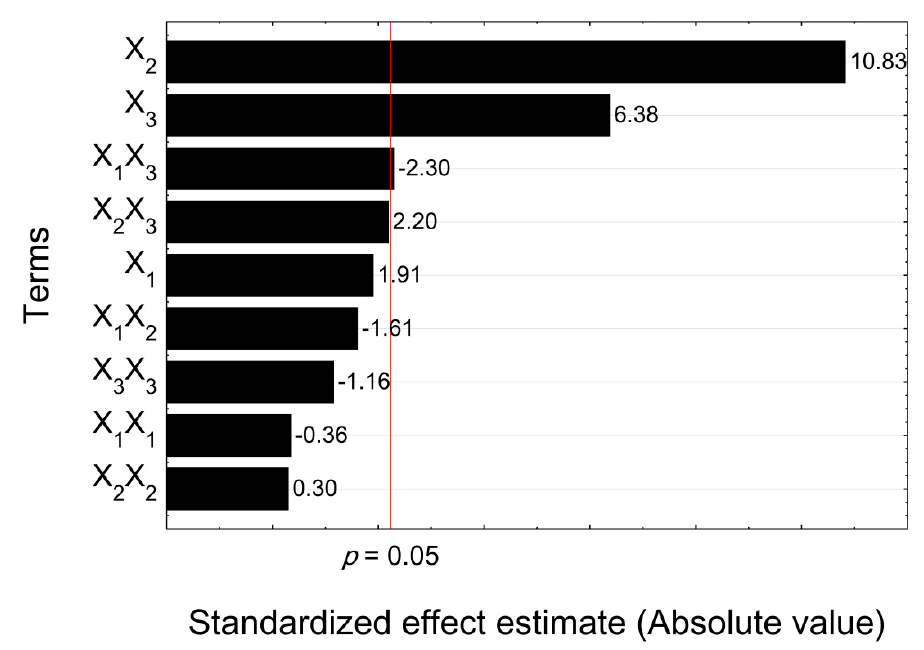
Figure 5. Pareto chart of standardized e ff ects ( X 1 , ethanol concentration; X 2 , extraction temperature; X 3 , extraction time).